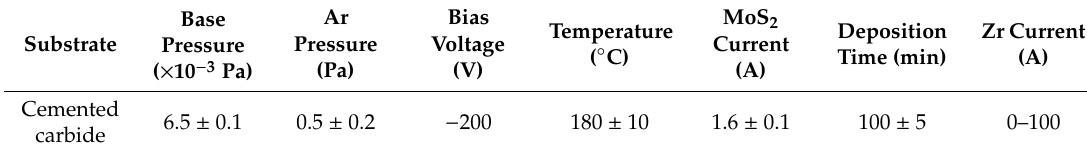
Table 2. The coating deposition